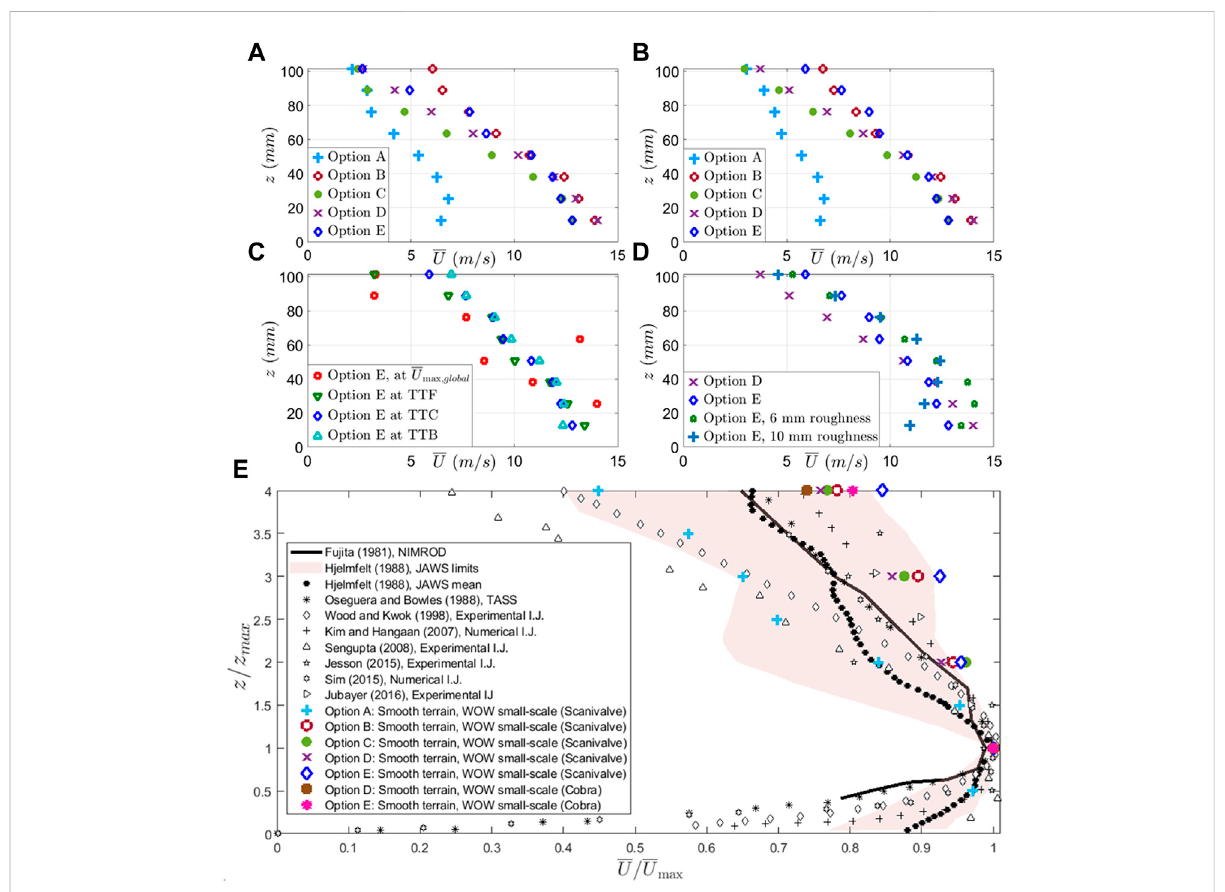
FIGURE 7 Vertical velocity pro fi les of normalized horizontal wind velocities for: (A) instantaneous wind velocities at TTC; (B) envelope wind velocities at TTC; (C) envelope of Option E at different horizontal distances; (D) envelope of Option D and Option E at TTC for different roughness; and (E) horizontal velocity pro fi le